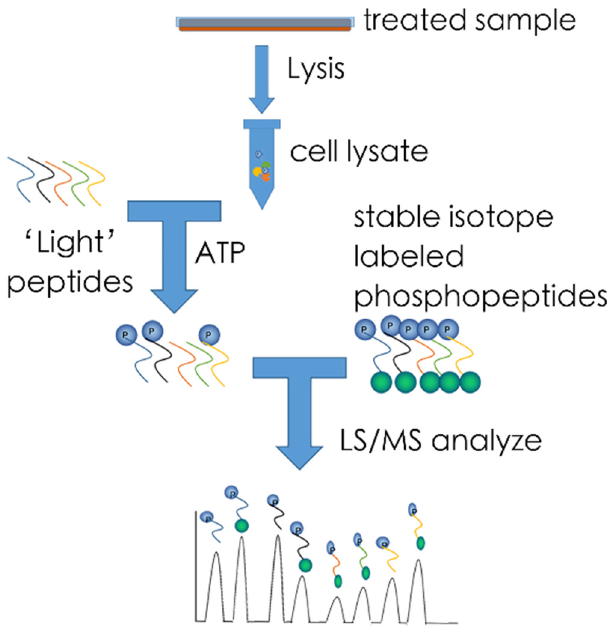
Figure 2. Kinase activity assay for kinome profiling (KAYAK). Synthetic substrate peptides are pooled and incubated with cell lysate. After quenching, isotope-labeled phosphopeptides of identical sequence to substrate peptides are added in a gnostic concentration to allow absolute quantifi- cation. Following enrichment of phosphorylated substrate peptides by immobilized metal-ion af- finity chromatography results are obtained by analysis through LC–MS. Pairs of light and heavy peptides differ in mass and can be quantified by calculating the ratio.